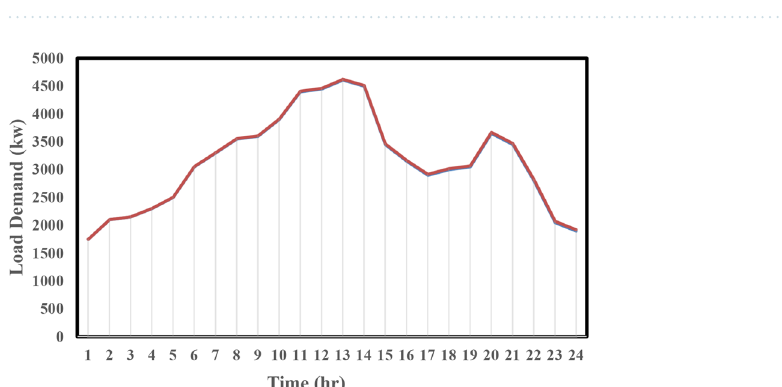
Figure 3. Modified IEEE 33-bus test system.